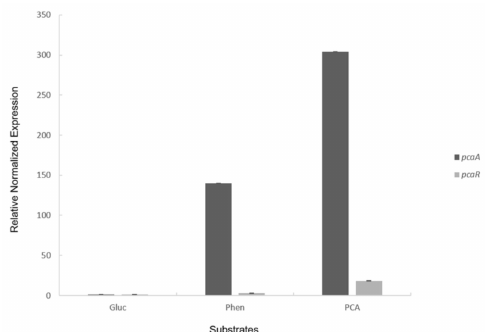
Figure 1. pca A and pca R gene expression quantification monitored by RT-qPCR in P. phenanthrenivorans Sphe3 grown on glucose, phenanthrene, and PCA as the sole carbon and energy source. Values represent the mean relative pca A and pca R expression normalized to the housekeeping gene gyr β ± standard deviations of three individual replicates. Gene expression levels in glucose were used as calibrator.